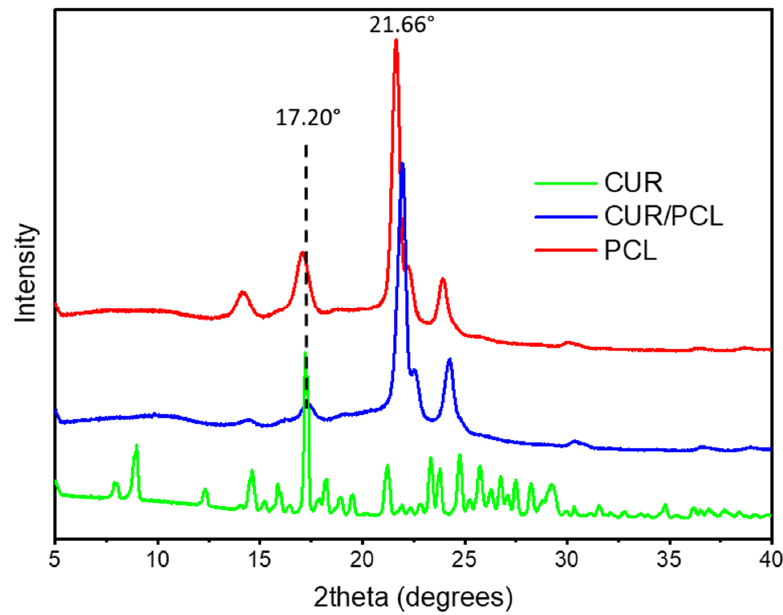
Figure 6. X-ray diffractograms of pure curcumin (CUR), blank PCL scaffold, and curcumin-loaded PCL scaffold (7%, w / w